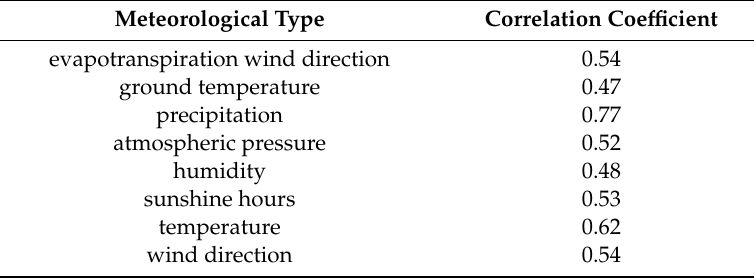
Table 3. The correlation coefficient between meteorological data and the downstream water-level.